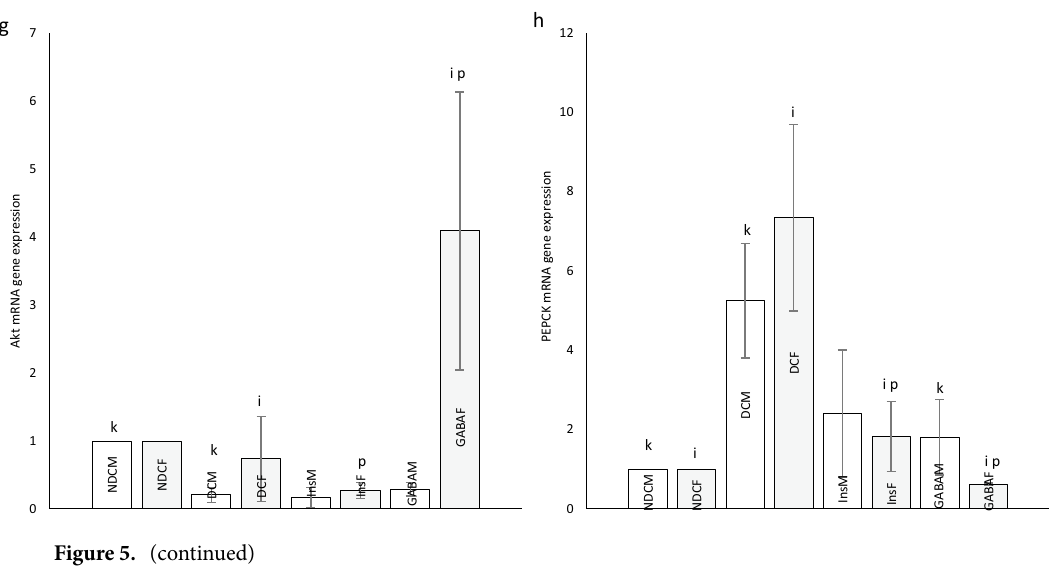
Figure 5. Foxo1 , Irs2 , Akt2 and Pepck mRNA expression : Comparison of Foxo1 ( a ), Irs2 ( b ), Akt2 ( c ) and Pepck ( d ) mRNA expression in male and female of non-diabetic control group (NDC) was fed with normal diet, diabetic control group received high-fat diet and 35 mg/kg STZ (DC), diabetic animals treated with 1.5 gr/kg GABA via IP injection (GABA), diabetic animals treated with insulin (2.5 U/kg twice per day) (Ins) and Foxo1 ( e ), Irs2 ( f ), Akt2 ( g )and Pepck ( h ) mRNA expression in their male and female offspring. (3 rats in offspring GABA groups and 5 rats in other groups, data are expressed as mean ± S.E.M). ( a ) Significant difference in Foxo1 , Irs2 , Akt2 and Pepck mRNA expression between female DC group and other female groups ( Foxo1 and Pepck :( P < 0.001); Irs2 : ( P < 0.05); Akt2 : ( P < 0.01)). ( b ) Significant difference in Foxo1, Irs2, Akt2 and Pepck mRNA expression b etween male DC group and other male groups ( Foxo1 :( P < 0.001); Irs2 and Pepck : ( P < 0.05); Akt2 : ( P < 0.01)). ( c ) Significant difference in Foxo1 , Irs2 , Akt2 and Pepck mRNA expression between female NDC group and other female groups ( P < 0.001). ( g ) Significant difference in Foxo1 , Irs2 , Akt2 and Pepck mRNA expression between female GABA group and female Ins group ( P < 0.001). ( h ) Significant difference in Foxo1 , Irs2 , Akt2 and Pepck mRNA expression between male GABA group male Ins group ( P < 0.01). ( i ) Significant difference in Foxo1 , Irs2 , Akt2 and Pepck mRNA expression between female offspring DC group and other female offspring groups ( Foxo1 and Irs2: ( P < 0.01(; Akt2 and Pepck : ( P < 0.05)(. ( k ) Significant difference in Foxo1, Irs2, Akt2 and Pepck mRNA expression b etween male offspring DC group and other male offspring groups ( P < 0.05(. ( m ) Significant difference in Foxo1 , Irs2 , Akt2 and Pepck mRNA expression between female offspring NDC group and other female offspring groups ( P < 0.05). ( p ) Significant difference in Foxo1 , Irs2 , Akt2 and Pepck mRNA expression between female offspring GABA group and female offspring Ins group ( Foxo1 and Irs2 :( P < 0.01); Akt2 and Pepck : ( P <